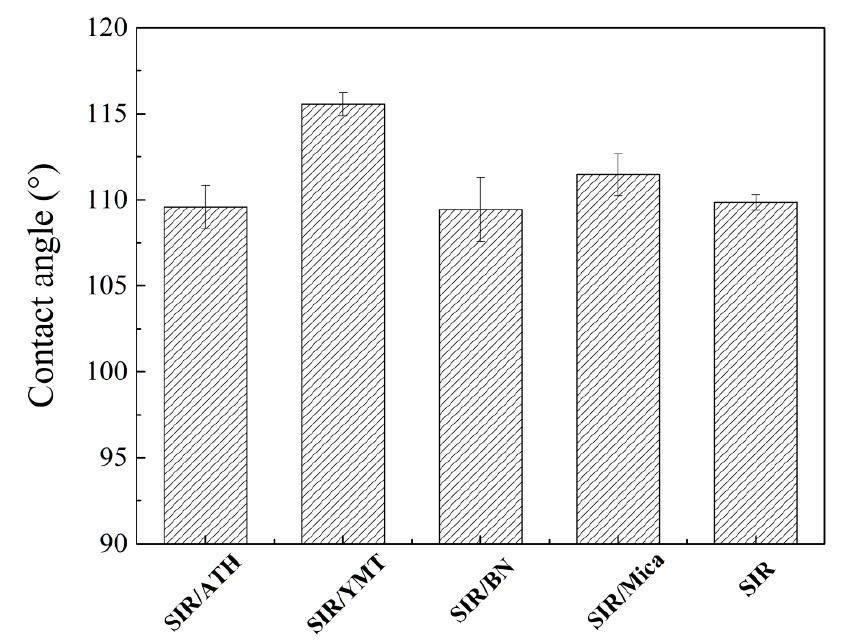
Figure 5. Static contact angle of SIR composites with various fillers.